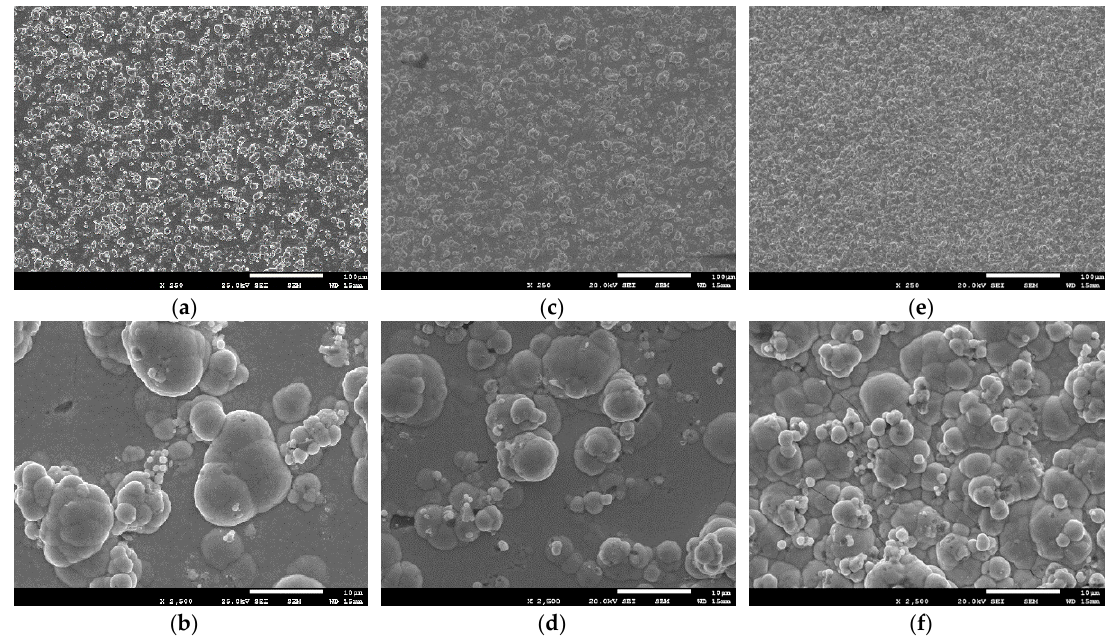
Figure 8. HRFE-SEM surface micrographs of Sn–Ni/TiO 2 composite coatings produced from a bath containing 30 g·L − 1 : ( a , b ) N,S-TiO 2 particles in the bath and applied J = 1 A·dm − 2 , ( c , d ) N,S-TiO 2 particles and J = 3 A·dm − 2 , and ( e , f ) Kronos 7000 TiO 2 particles and J = 3 A·dm − 2 . Table 3. TiO 2 incorporation (wt.%), average grain size (nm), and roughness ( µ m) values of pure Sn–Ni and composite Sn–Ni / doped-TiO 2 coatings as deduced be EDAX, XRD, and Profilometry